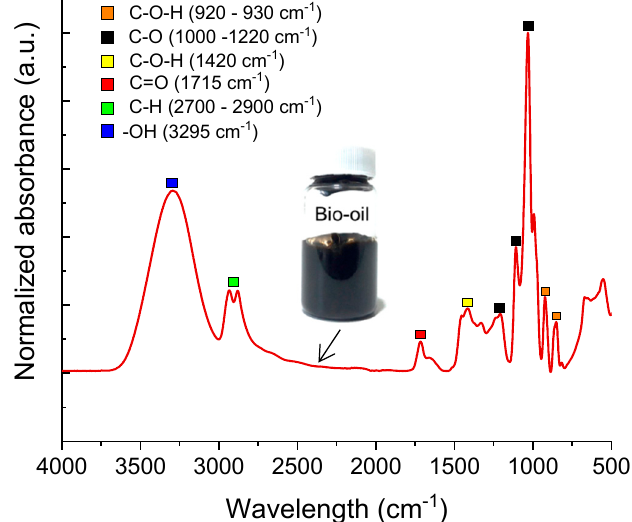
Figure 9. Normalized infrared spectra of BO obtained from liquefaction of corn stover residues. The assignment of spectral bands was carried out based on that previously reported by Lievens et al. [25] and Stuart [26] on BO and oxygen-containing compounds.